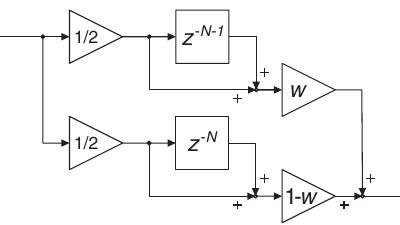
FIG. 12. Block diagram of a combined notch filter whose frequency can be chosen freely.